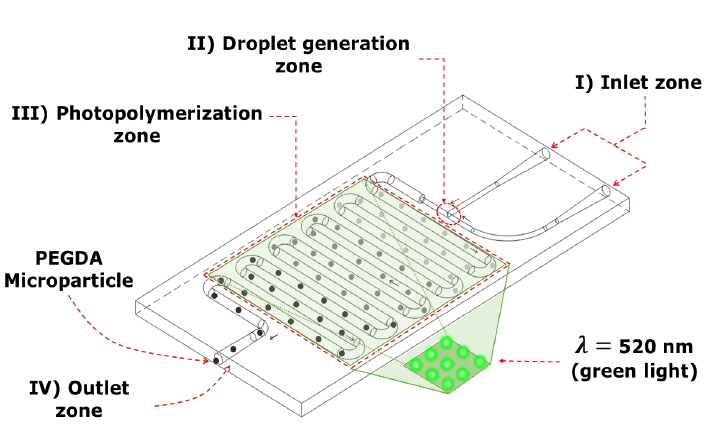
Figure 2. Design of a microfluidic device with four zones. (I) Inlet zone, (II) droplet generation zone, (III) photopolymerization zone and (IV) outlet zone. Green LEDs are used for the photopolymeriza- tion process. The microfluidic device design was made of poly-dimethyl siloxane (PDMS, Syl- gard 184, Dow Corning)